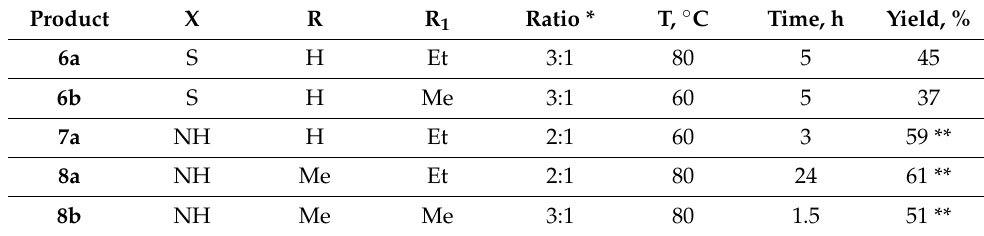
Table 1. The reaction conditions and yields of 6 – 8 a , b , prepared according to Scheme 1.